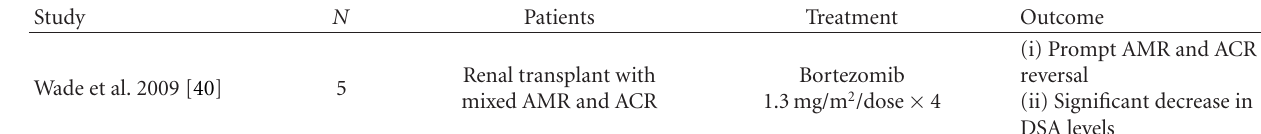
Table 1: Published studies of the use of bortezomib in AMR